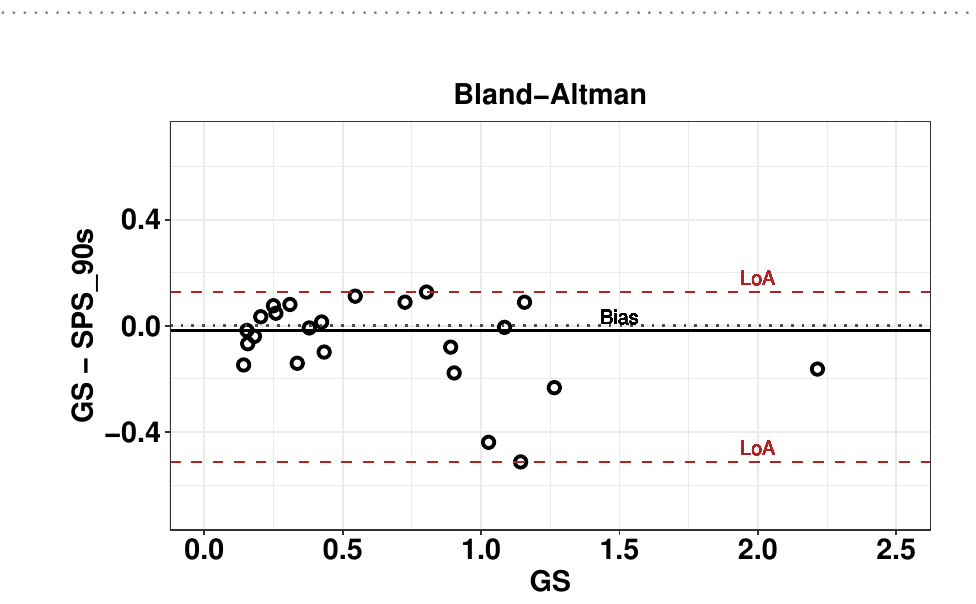
Figure 12: Analysis of the Bland-Altman plot to study the concordance between the GS and the 90 sseries of the SPS index.